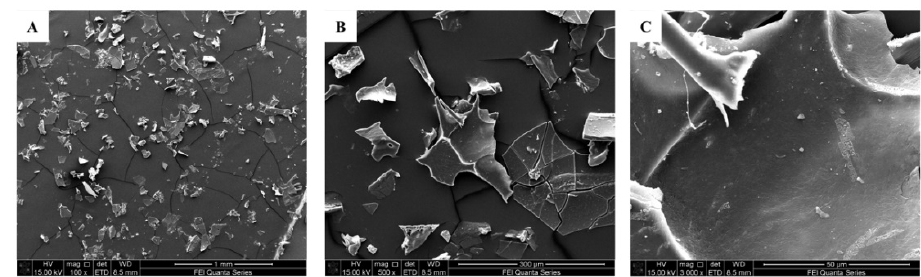
Figure 4. SEM images of GEP-1 at different magnifications ( A : 100 × ; B : 500 × ; C : 3000 × ).